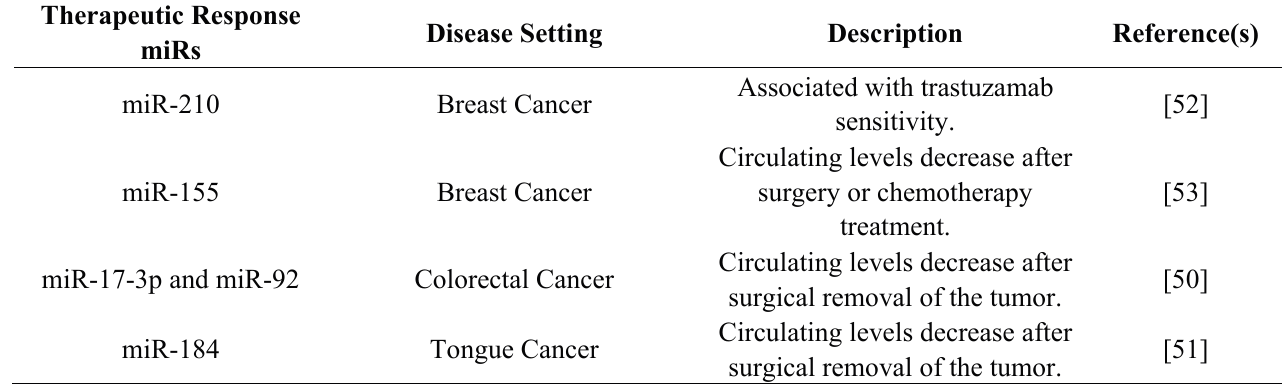
Table 3. Circulating microRNAs with potential for predicting therapeutic